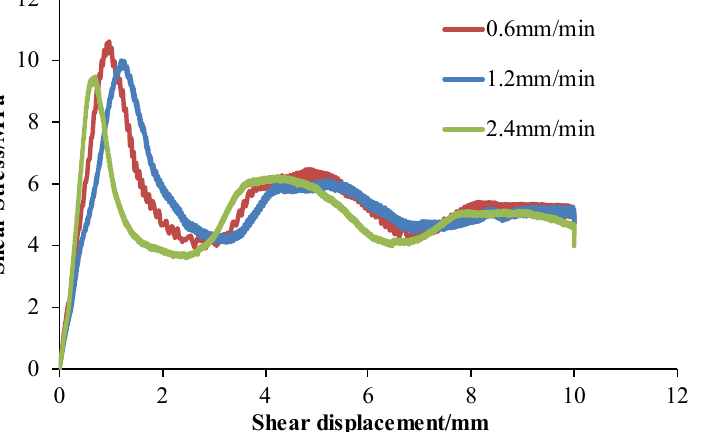
Figure 12. Shear stress–displacement curves under different shear rates at 4 MPa normal stress with a 30° undulating angle.